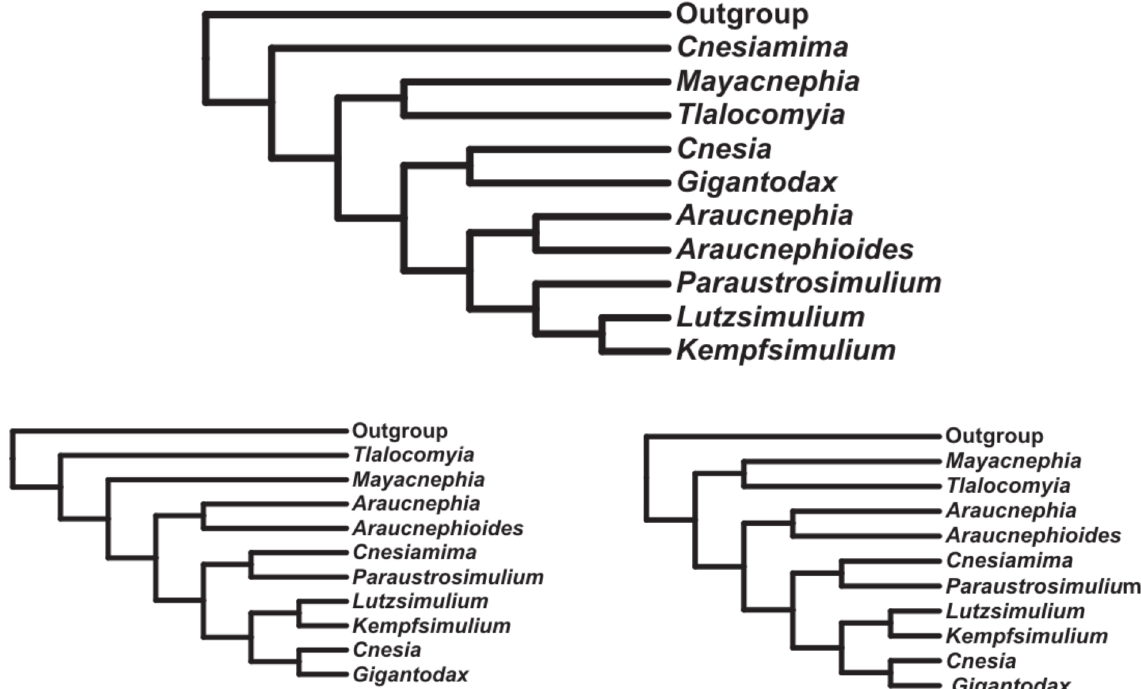
Figure 2. The three most parsimonious trees obtained from the analysis of Py-Daniel’s (1982) data